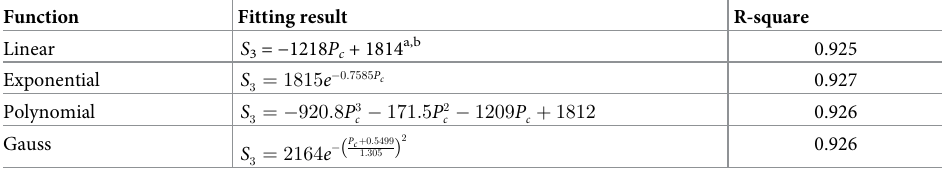
Table 7. Functions between saturation flow rate and lane changing proportion.